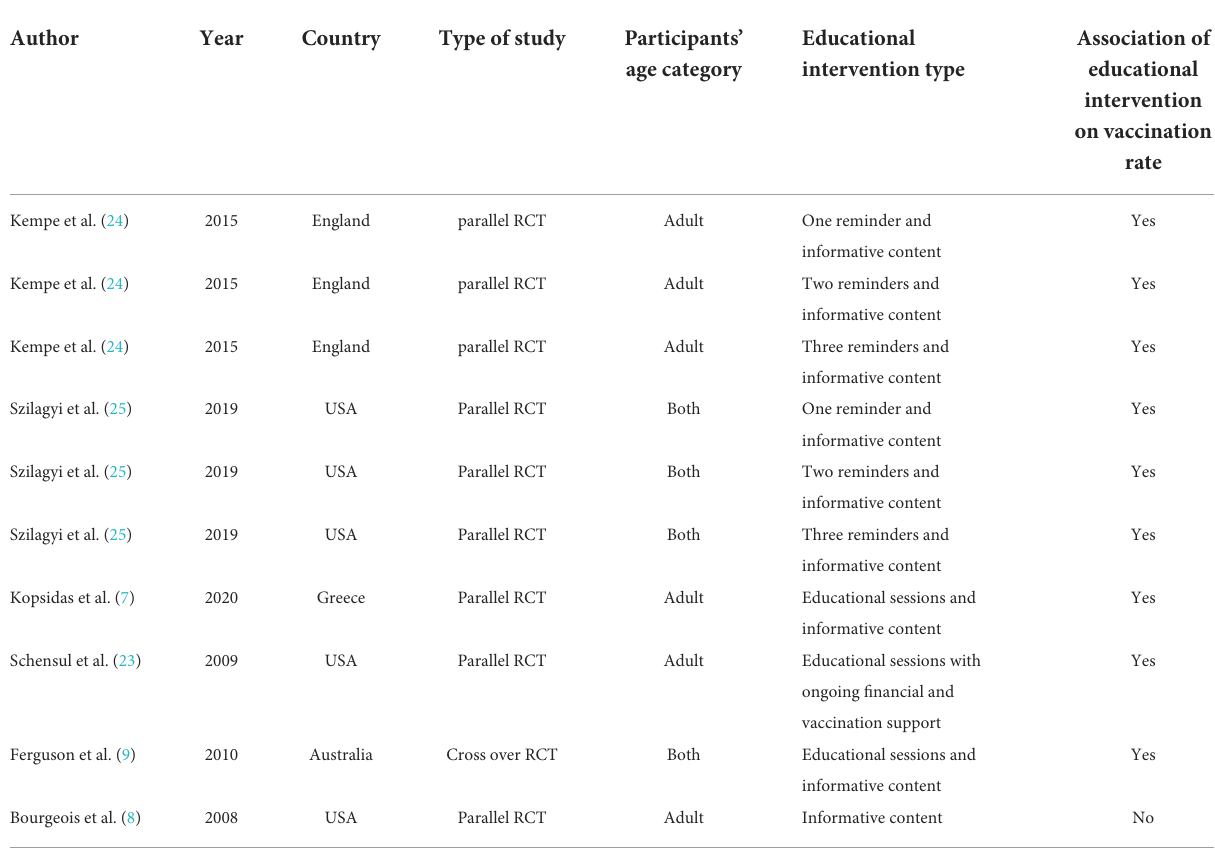
TABLE 2 The association of educational interventions on vaccination rate.